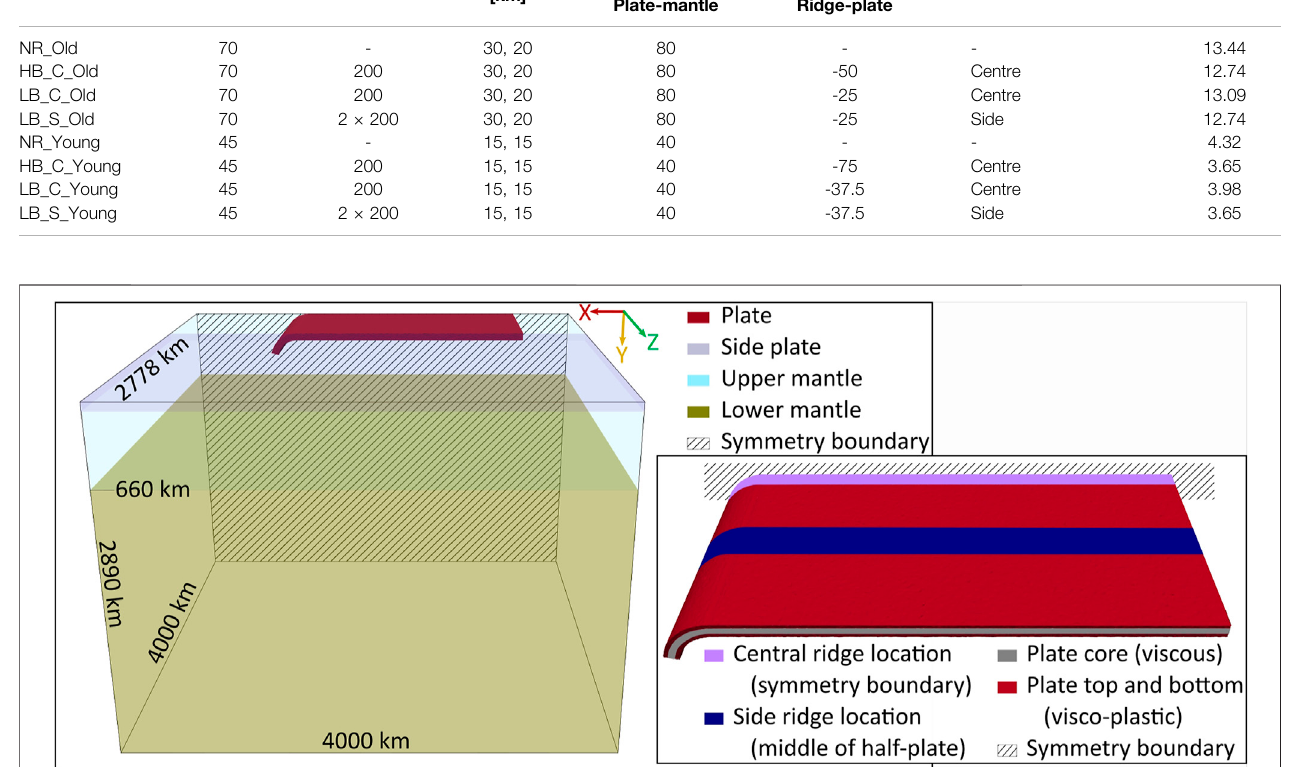
FIGURE 1 | Initial conditions of (A) our computational domain and (B) the subducting plate. See text and Tables 1 , 2 for material properties and dimensions. We apply a free-surface boundary condition at the top of the domain, and free-slip boundary conditions elsewhere.